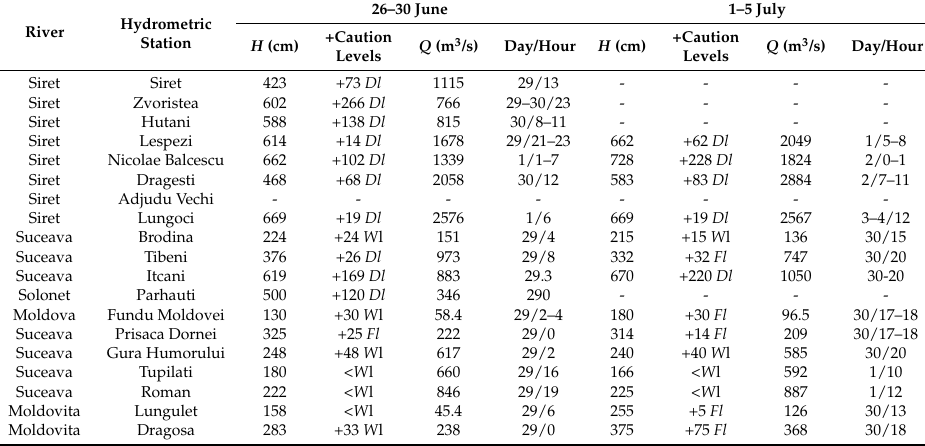
Table 4. Maximum levels and values exceeding caution levels between 26 June and 5 July 2010 for the main hydrometric stations in the Siret river